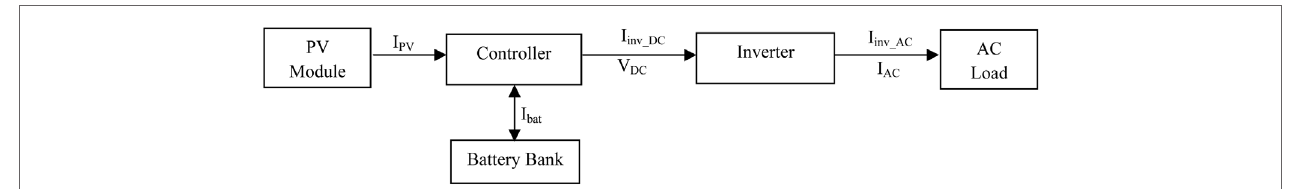
FigUre 4 | Model of the proposed PV-battery system (ani and ani,